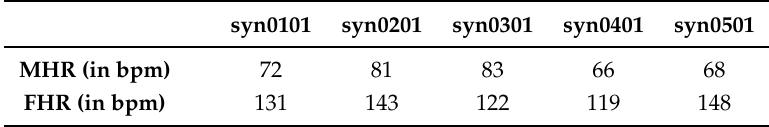
Table 3. Combination of maternal and fetal heart rates used to generate synthetic (syn) abdominal signals. MHR, Maternal Heart Rate; FHR, Fetal Heart Rate.